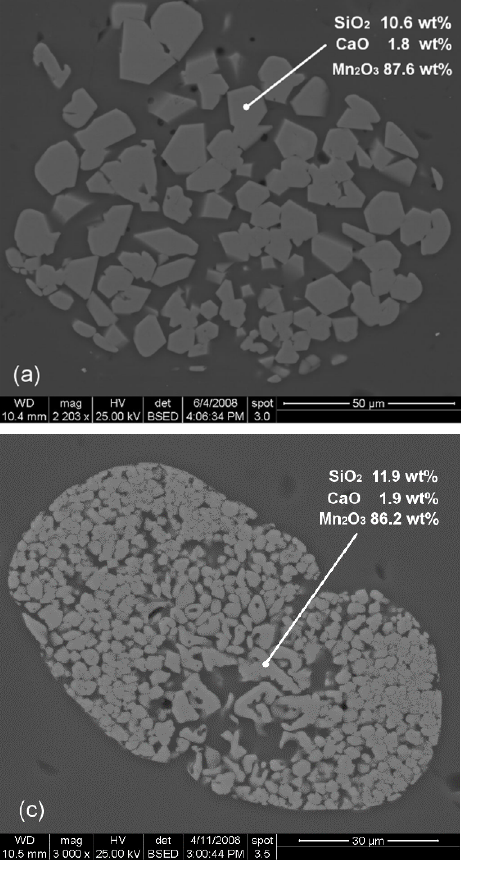
Figure 3. SEM-BSE images of manganese-containing inclusions in Padova tesserae PD-NC1 ( a ), PD-NC2 ( b ), PD-PR2 ( c ) and PD-PR3 ( d ). Note the same micro-texture and habit of manganese aggregates, independently from chromatic group. EDS compositional data are also reported within each